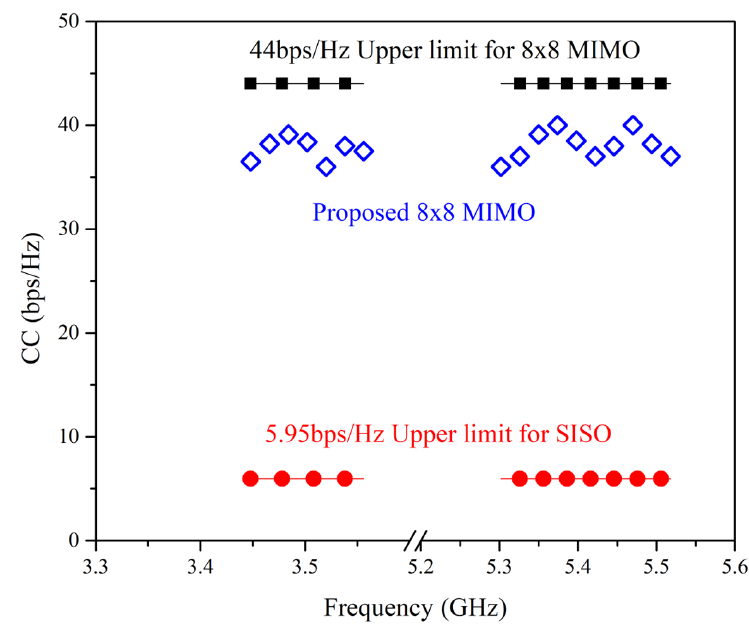
Figure 12. CC of the proposed MIMO antenna at an SNR of 20 dB.